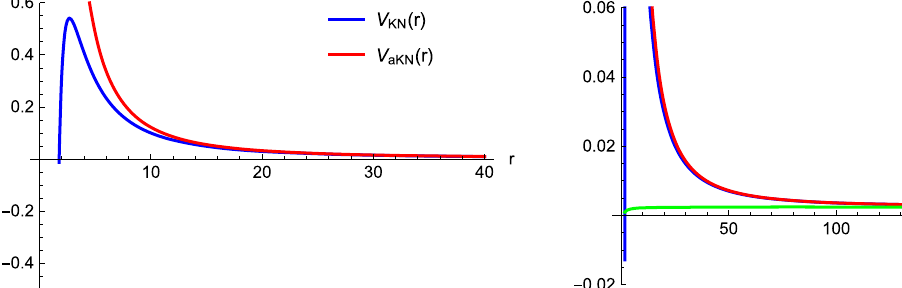
(Right) V KN ( r + ) is finite ( − 0 . 013) like as ω 2 − (ω − ω c ) 2 = − 0 . 012. V aaKN ( r ) could imitate V KN ( r ) for r ≥ 150. We check the condition of ω < ω c = 0 . 13 and ω < μ in Eq. (28)